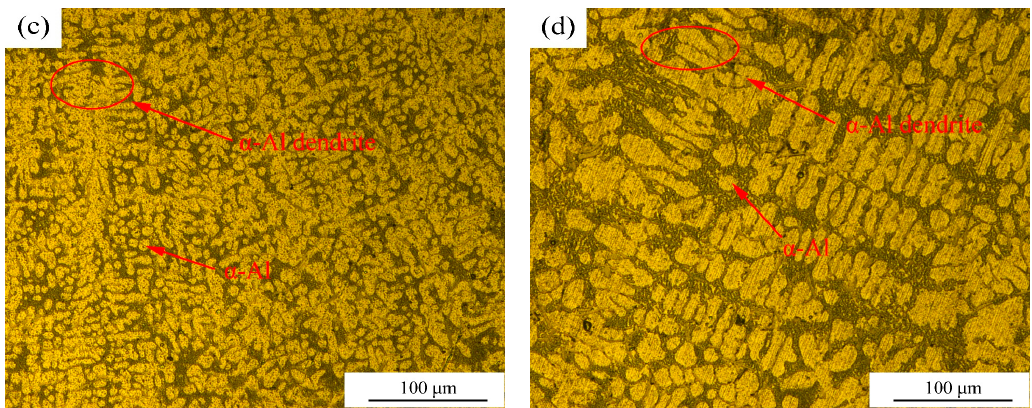
Figure 2. Effects of rare earth Yb addition on α -Al phases in as-cast ADC12 alloys: ( a ) unmodified; ( b ) 0.4 wt % Yb; ( c ) 0.8 wt % Yb; ( d ) 1.2 wt % Yb.